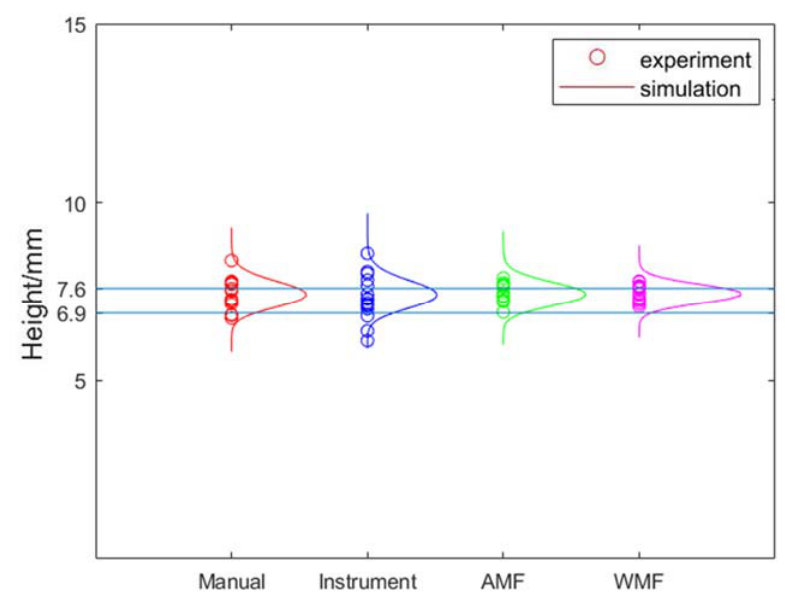
Figure 10. The effect of measuring crack a from bottom ‐ surface by K2.5 Probe.